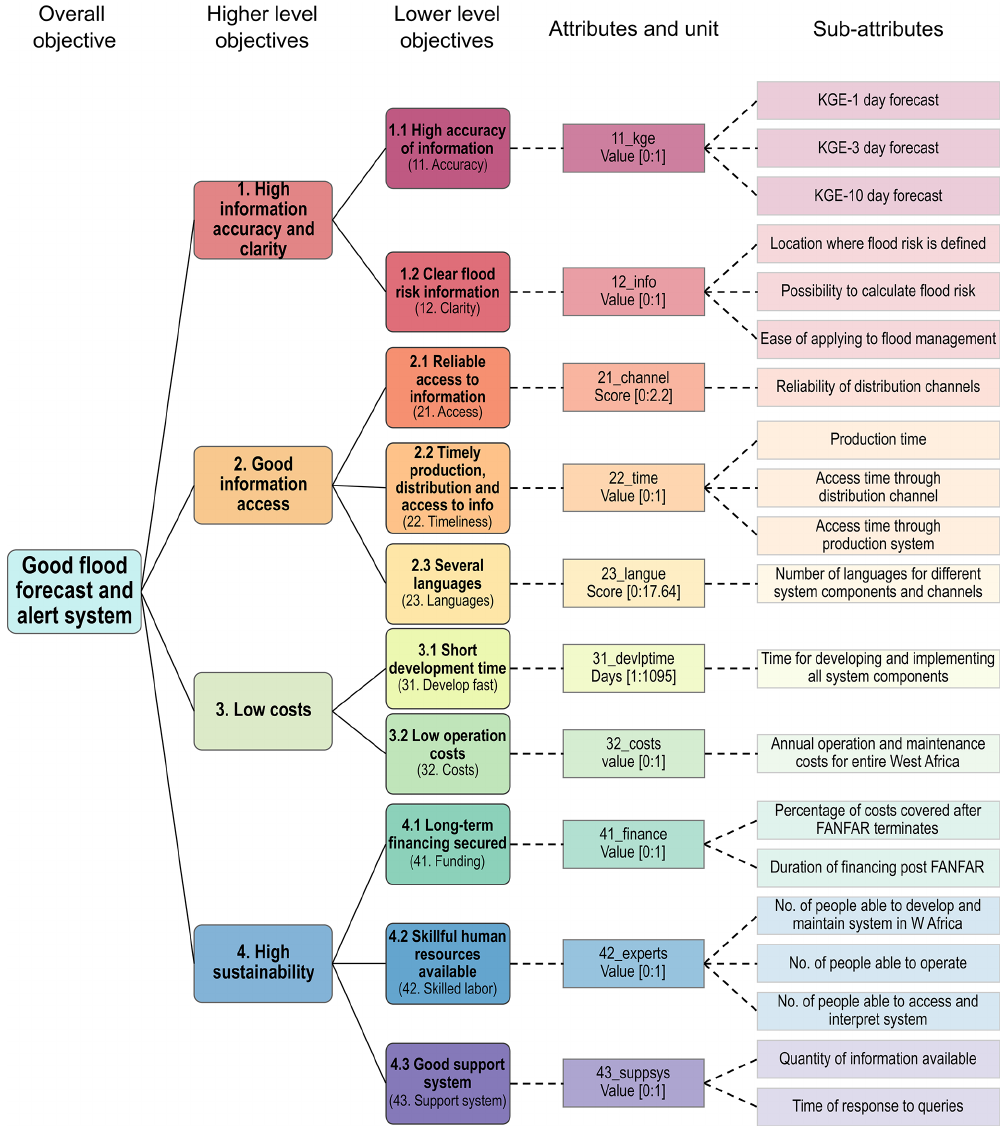
Figure 2. Objectives hierarchy. From left to right: overall objective, 4 higher-level fundamental objectives, 10 lower-level fundamental objectives (short names in brackets) and corresponding attributes, and the attributes’ unit (usually a value) and range (square brackets), from worst (usually value 0) to best (usually value 1). Most attributes were constructed from sub-attributes (far